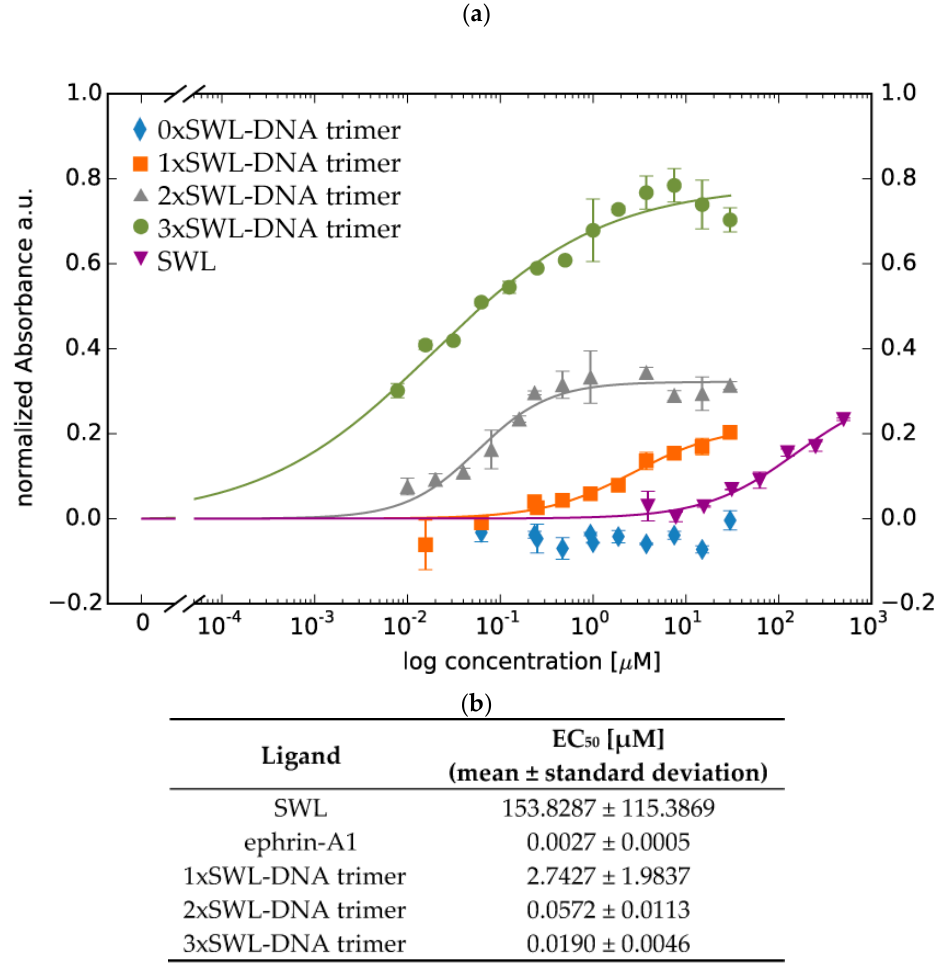
Figure 4. Quantitative analysis of phosphorylation of EphA2 receptors. Serum-starved PC-3 cells were treated with different concentrations of constructs in duplicates for 30 min at 37 °C. Cells were washed with 1× PBS twice and further treated according to the manufacturer’s instructions. ( a ) Displayed data points are averages of normalized net absorbance (difference between absorbance at 520 nm versus 450 nm); the net absorbance signal in the presence of different entity concentrations was normalized to the signal from treatment with 1× PBS/10 mM MgCl 2 only (without any peptide or DNA constructs) resulting in normalized absorbance. Standard deviation is presented as error bars. The x-axis indicates concentrations of the constructs in terms of DNA for 0xSWL-DNA trimer—3xSWL-DNA trimer and the concentration of the peptide for SWL. It should be understood that the x-axis displays concentrations for whole entities not for binding entities (in this case SWL molecules). ( b ) EC 50 values of different ligands for EphA2 receptor phosphorylation resulting from fitting (solid lines in Figure 4a, Equation (1)).